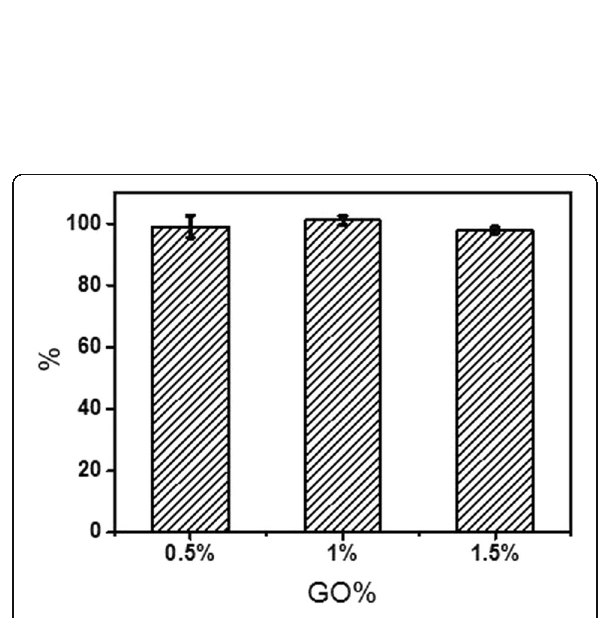
Fig. 7 The relative activity of HIH-373 cells in nHAC/PLGA(0.5, 1, 1.5 wt%) relate to